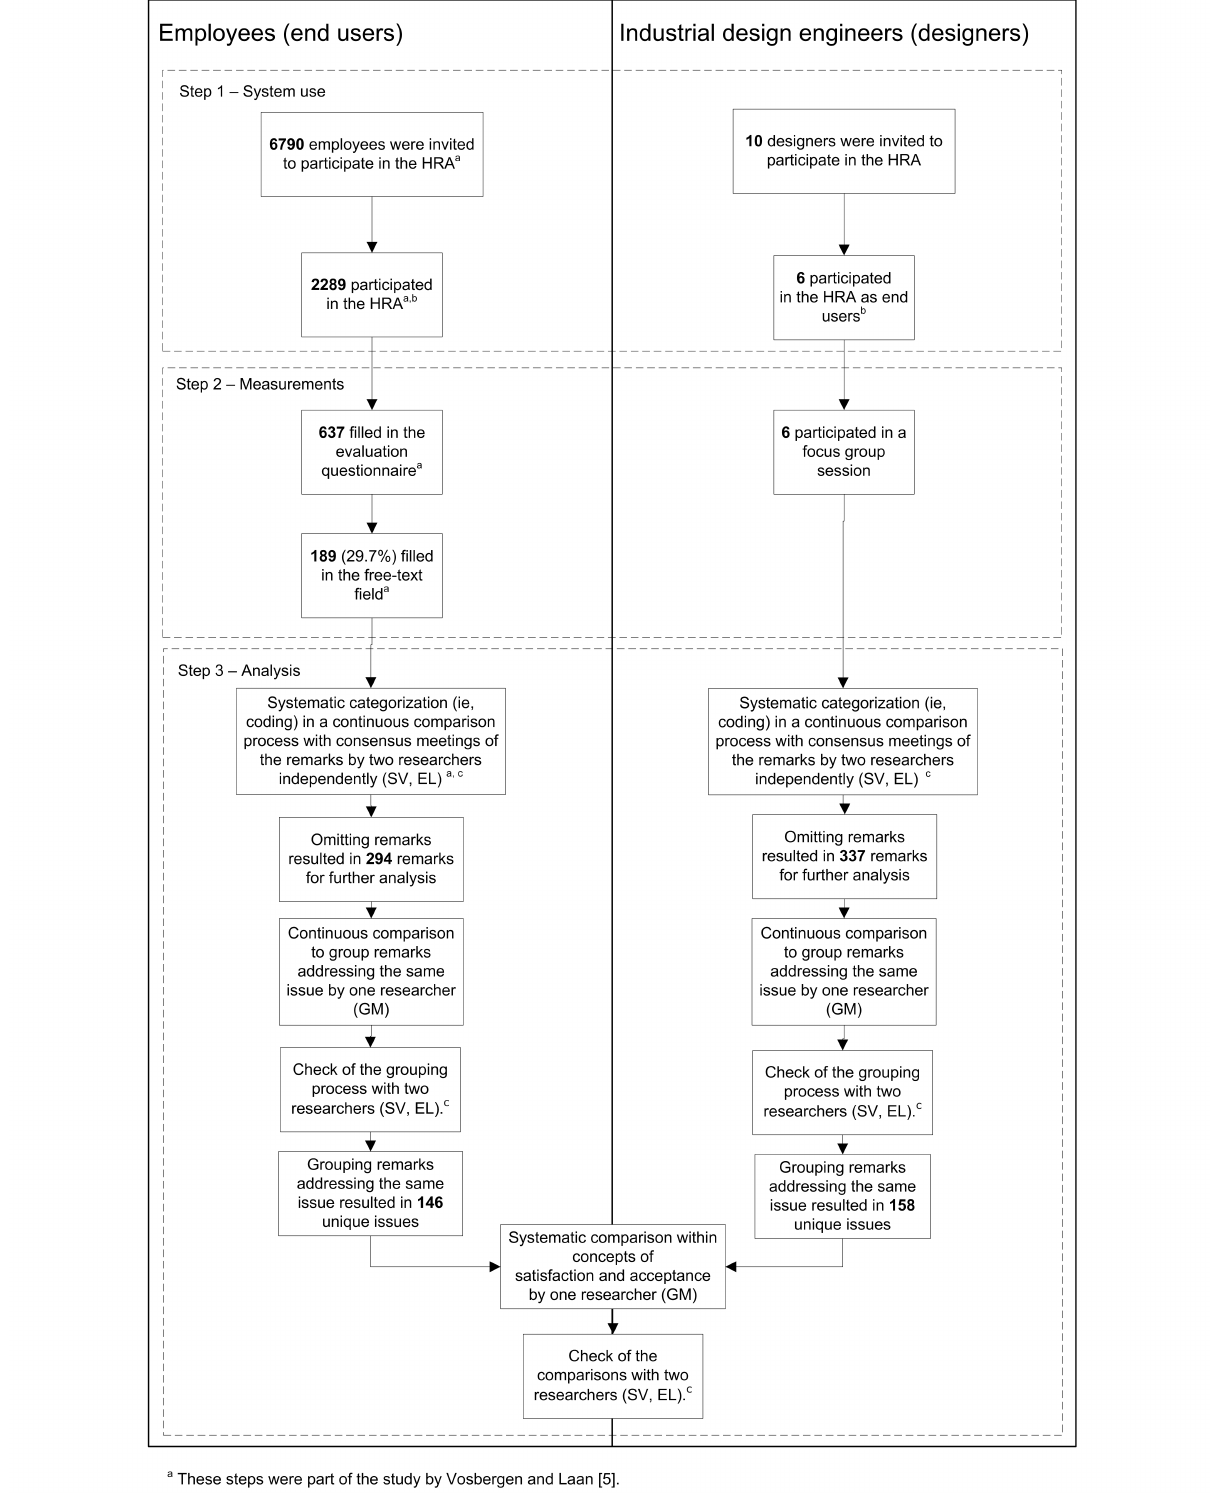
Figure 1. Study design and participant